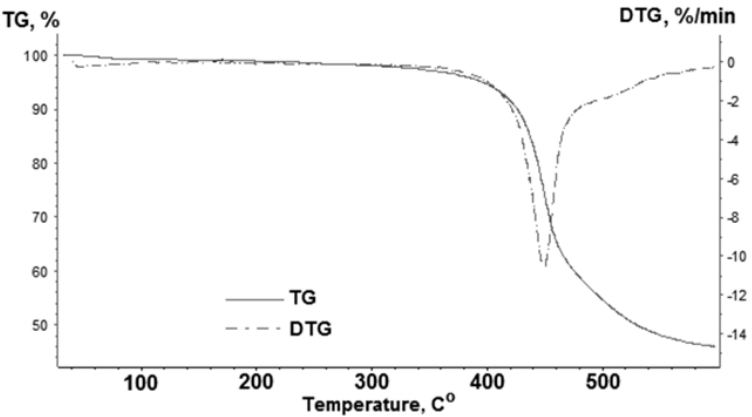
Figure 1. Results of thermogravimetric analysis of HPS MN270.